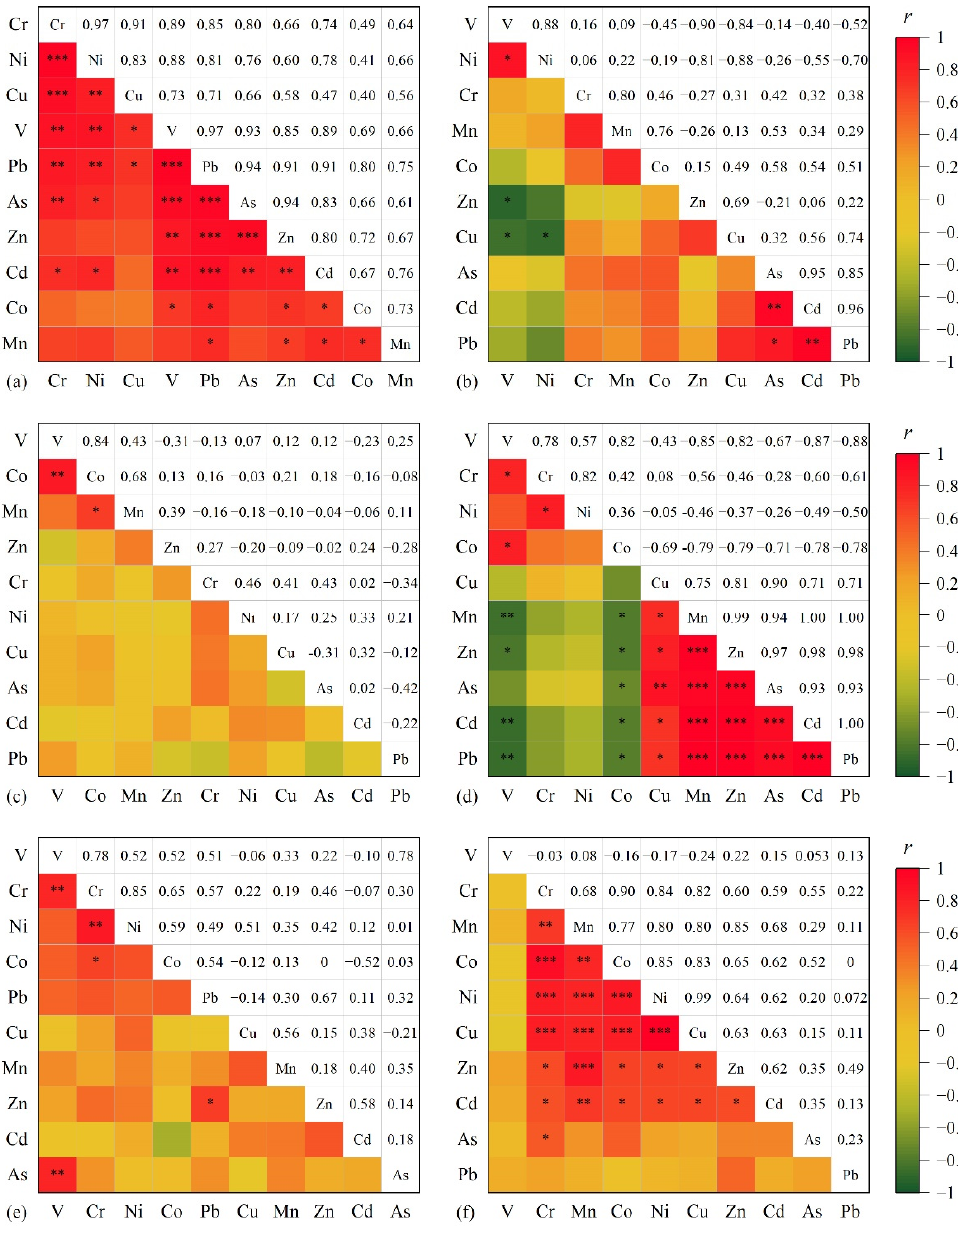
Figure 4. Pearson’s correlation coefficients of potentially toxic elements in PM 2.5 of soil fugitive dust. ( a ) Baoshan; ( b ) Honghe; ( c ) Kunming; ( d ) Yuxi; ( e ) Wenshan; ( f ) Zhaotong. * Showed significant correlation at the 0.05 level; ** Showed significant correlation at the 0.01 level; *** Showed significant correlation at the 0.001 level.